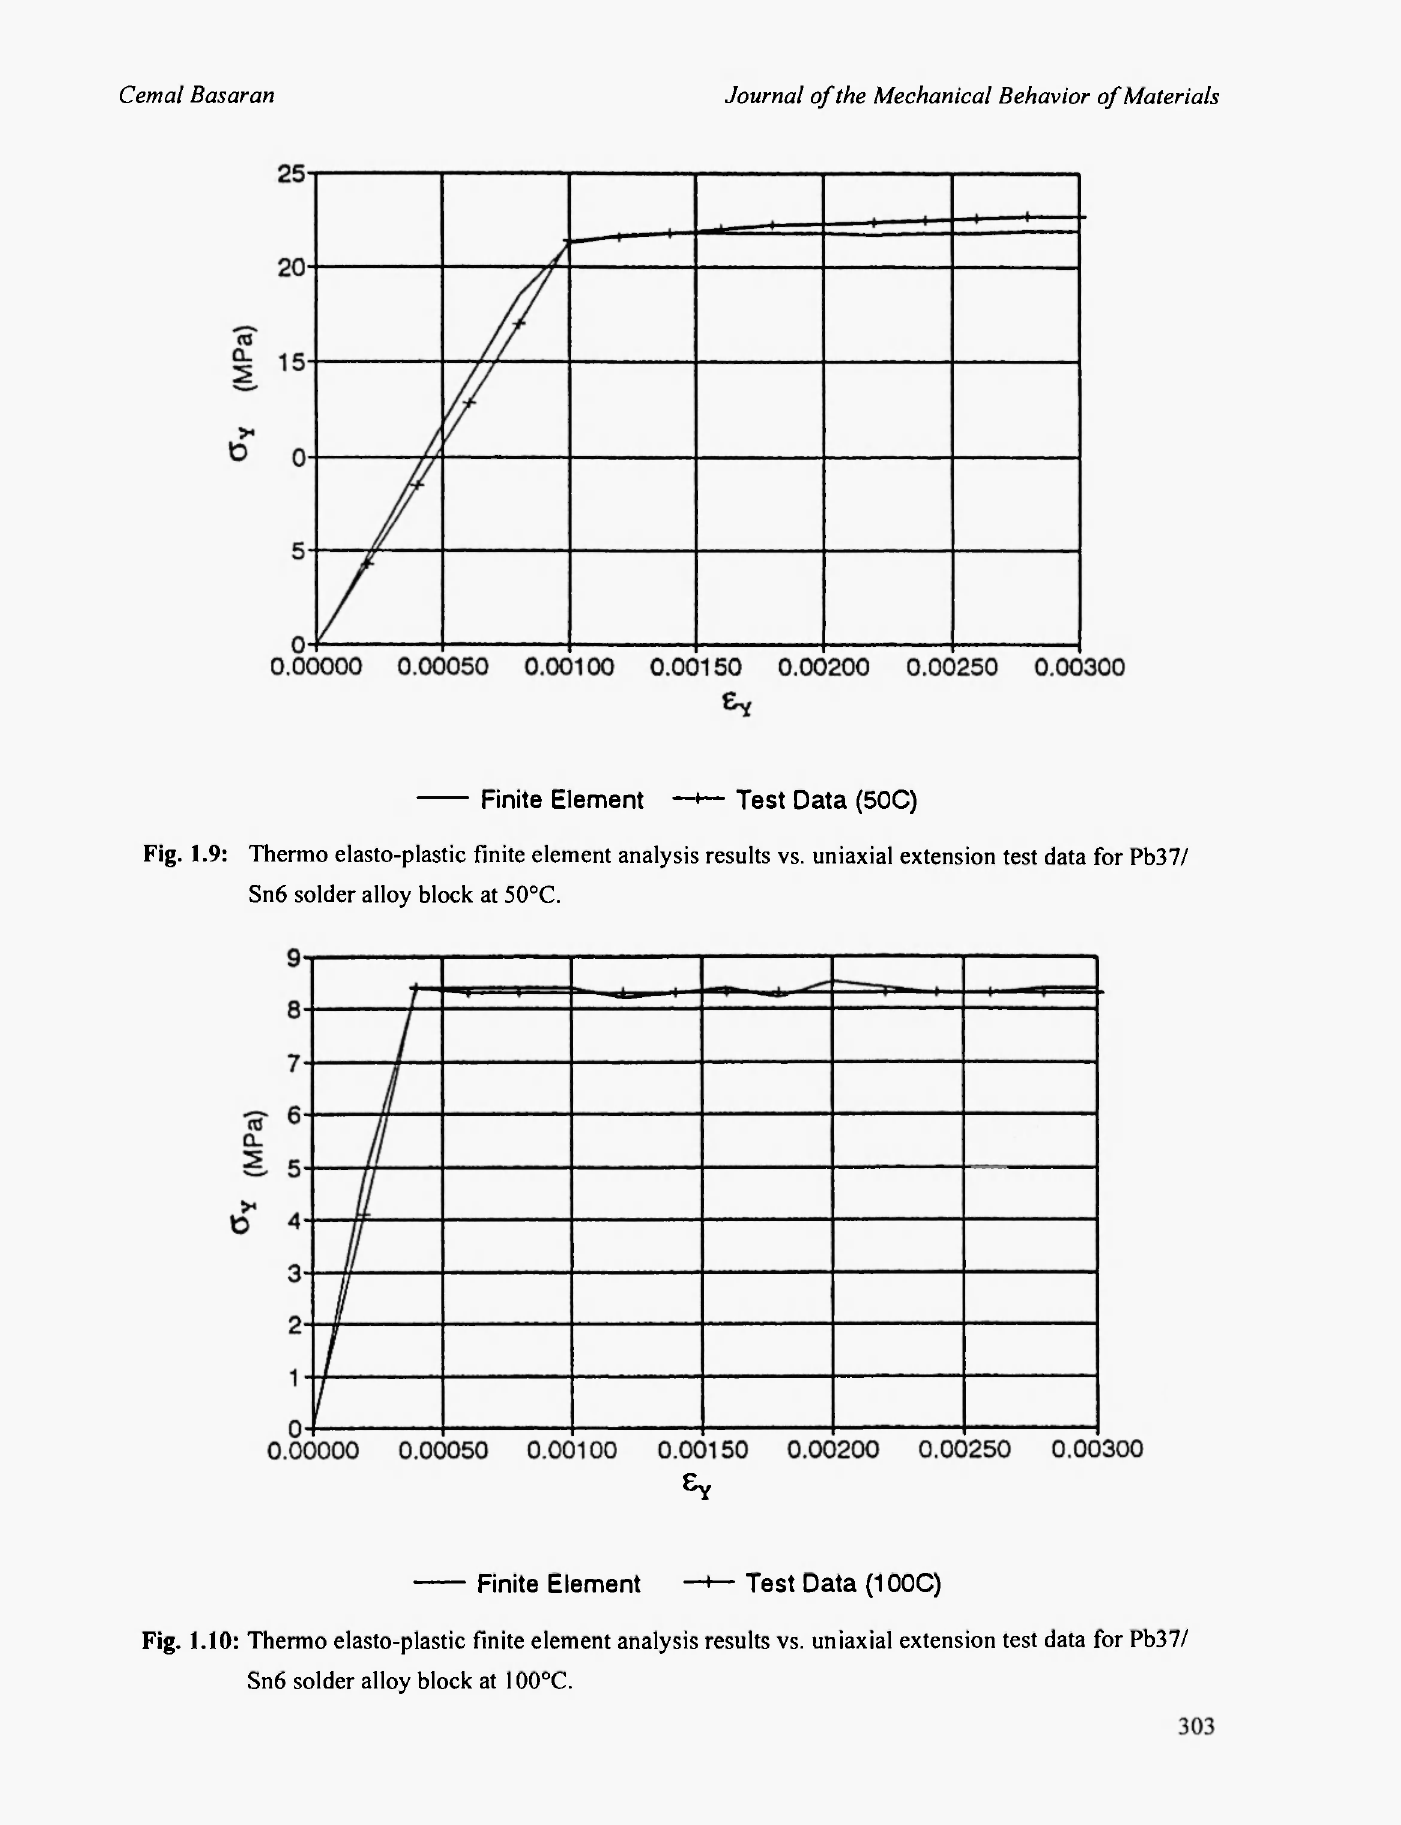
Fig. 1.9: Thermo elasto-plastic finite element analysis results vs. uniaxial extension test data for Pb37/ Sn6 solder alloy block at 50°C.